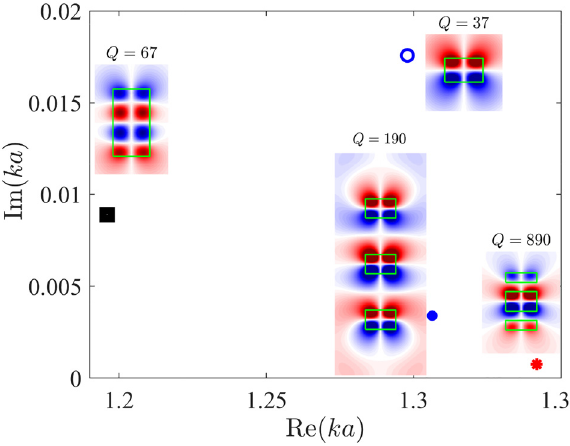
Figure 3: The Q -factors, resonant eigenfrequencies, and corresponding resonant modes. The first panel: a single solid disk with sizes identical to the DS shown in the fourth panel. The second = 1 . 244 separated panel: three identical disks with heights h = h 1 by L = 2 . 38 tuned to the symmetry protected quasi-BIC. The third = 0 . 616. The fourth panel: the panel: a solitary disk with height h 1 same disk as in third panel inserted symmetrically inside a dimer = 0 . 616 , L = 0 . 592. with h 1